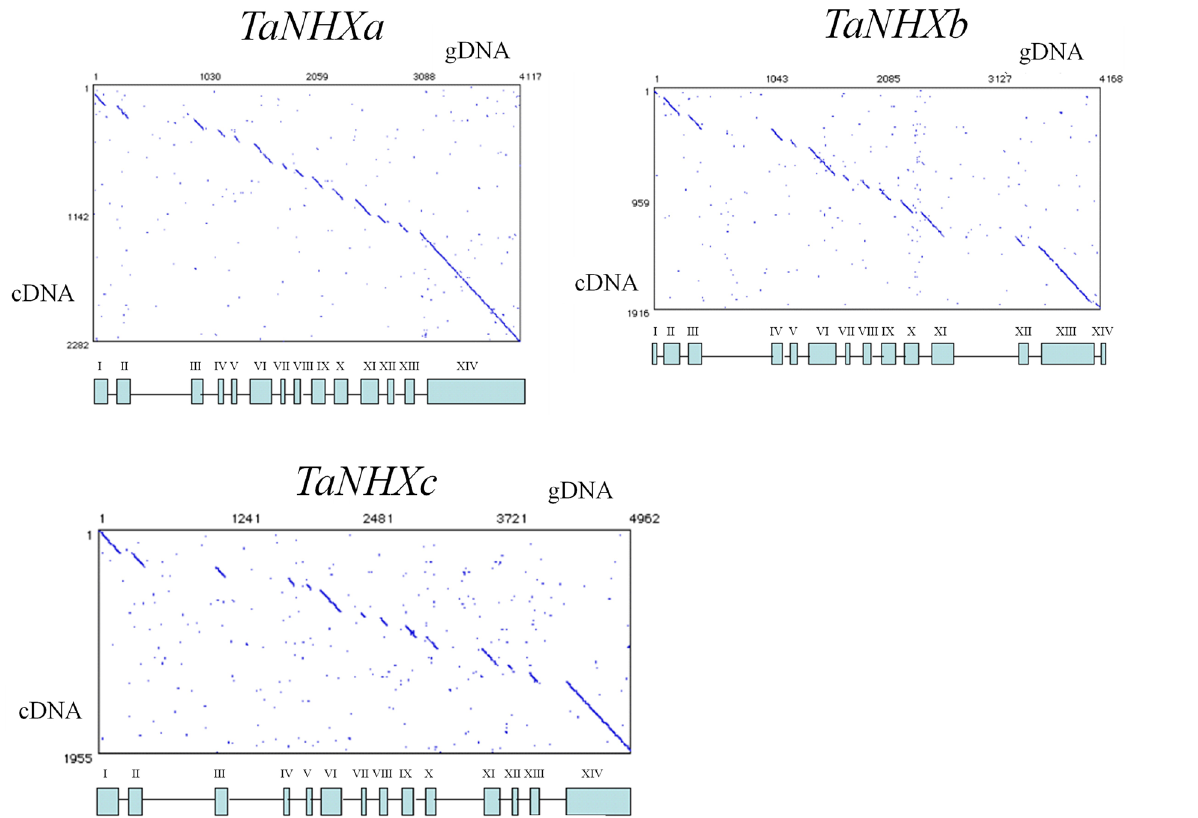
Figure 4 – Exon/intron structure of Na + /H + antiporter-like genes of bread wheat revealed by comparison of genomic DNA and cDNA. The nucleotide sequences of genomic DNA fragments amplified by PCR were determined. For the TaNHXa gene, nucleotide sequences of 4,255 bp (GenBank accession number, MT549998) in total length were determined by obtaining DNA fragments of 1.9 kb from the central region, of 290 bp and 1.3 kb from the 5' tip end, and of 1.1 kb from the 3' tip end. For the TaNHXb gene, nucleotide sequences of 4,167 bp (MT549999) bp in total length were determined by obtaining DNA fragments of 2.2 kb from the central region, of 370 bp and 1,410 bp from the 5' tip end, and of 630 bp and 430 bp from the 3' tip end. For the TaNHXc gene, nucleotide sequences of 4,962 bp (MT550000) in total length were determined by obtaining DNA fragments of 944 bp from the 5' tip end, 2.7 kb from the central region and 570 bp from the 3' tip end. The exon/intron structures of the TaNHX genes were determined by comparing cDNA and genomic DNA. This figure shows exon/intron structures clarified by homologous regions of genomic DNA of TaNHXa , b , and c with their cDNA. Each TaNHX consisted with 14 exons and 13 introns. Exon sizes ranged from a maximum of 489 bp to a minimum of 47 bp, while introns ranged from a maximum of 653 bp to a minimum of 34 bp in TaNHXb . Exon sizes ranged from a maximum of 605 bp to a minimum of 47 bp, while intron sizes ranged from a maximum of 462 bp to a minimum of 77 bp in TaNHXc